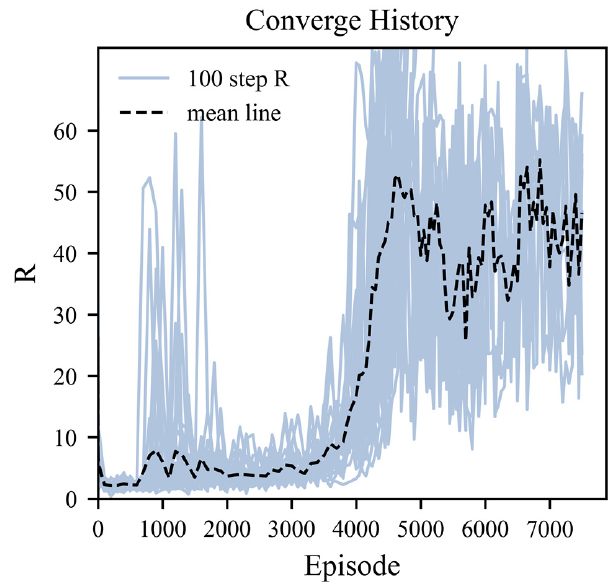
Figure 24. Convergence history of the agent.